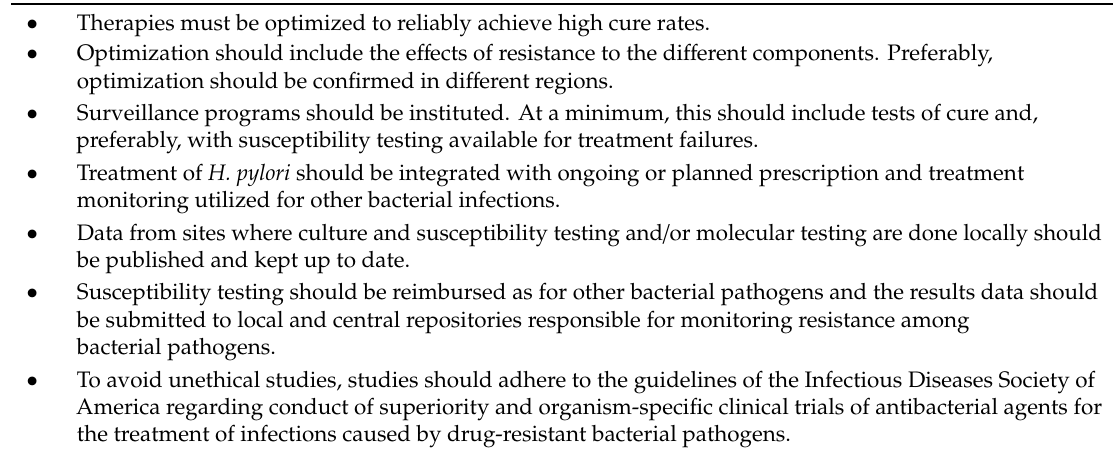
Table 2. Guidelines to implement antimicrobial stewardship for treatment of H. pylori